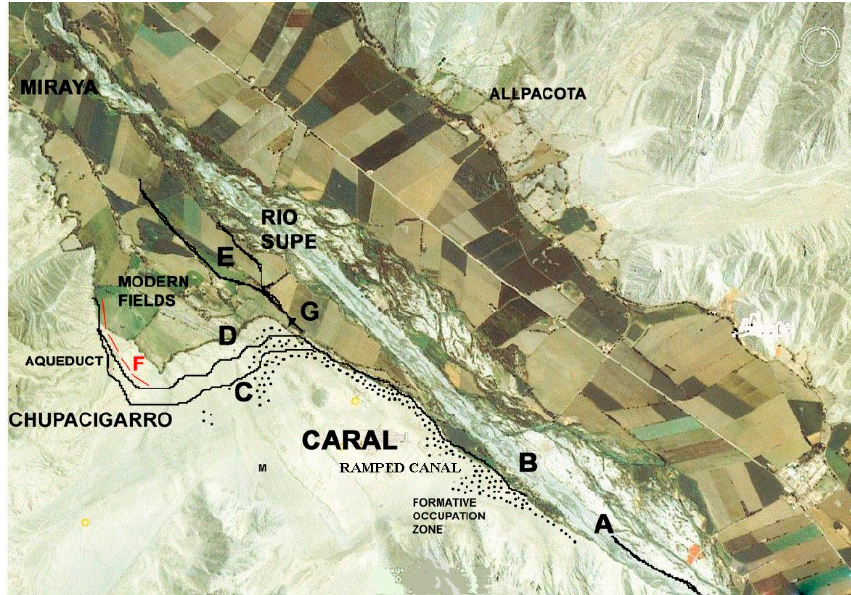
Figure 15. Path of the Ramped Canal to the Chupacigarro site. Current agricultural (brown and black) areas extend to both sides of the Supe River. Figure 14 and the current figure show the canal inlet (A) located in the far upstream reaches of the Supe River. The notation B denotes Early Formative Period sites; C and D canals supplied the early site of Chupacigarro located at (red) F. The E and G locations are modern in-use bottomland fields irrigated by high groundwater levels. Figure 15 indicates that the Ramped Canal extension was the water source for the canals on the Caral plateau as well as the water source for the older Chupacigarro site